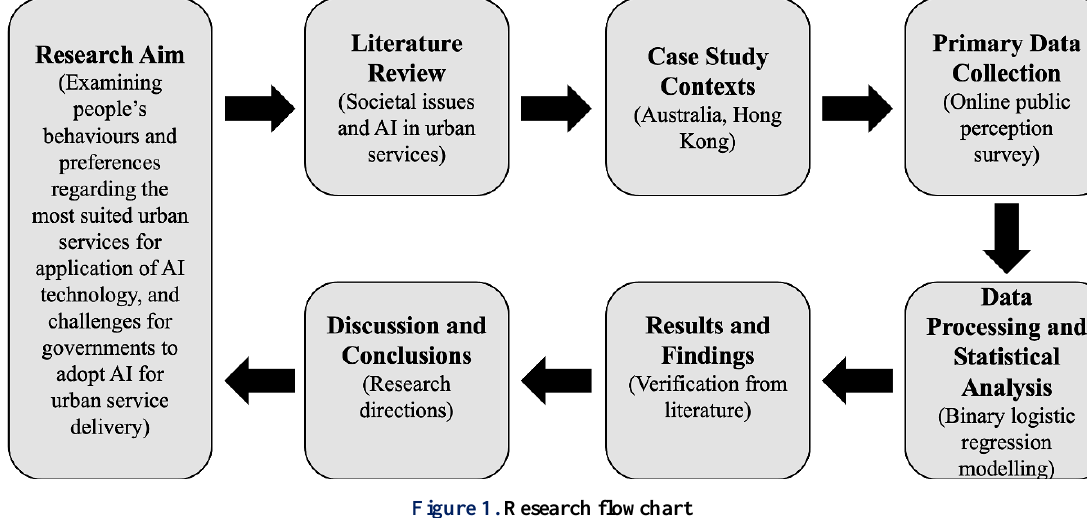
Figure 1. Research